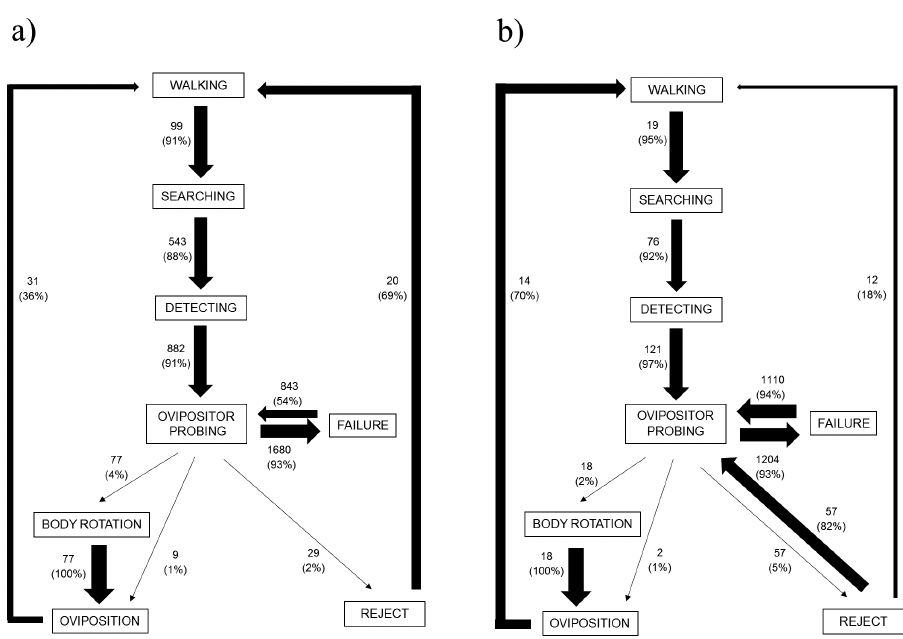
Figure 1. Ethogram of oviposition of females of Doryctobracon crawfordi on non-parasitized larvae ( a ) and larvae previously parasitized by conspecifics ( b ) under laboratory conditions. The width of the arrow is proportional to the relative frequency of transition. The numbers associated with the arrows represent the observed frequencies of the successive behaviors of a complex sequence of behavior (proportions are indicated in